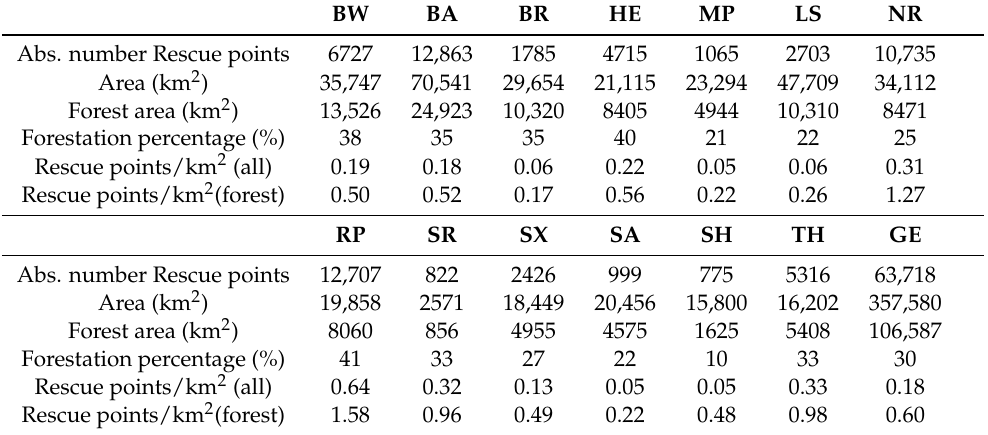
cumulative distribution of the individual distances for each of the RSPs within the forest area (n = 3,189,44). Table 2. Standard indices of the rescue point of the areas and the rescue points for the federal states and the federal level. Abbr.: Baden-Württemberg (BW), Bavaria (BA), Brandenburg (BR), Hesse (HE), Mecklenburg Western Pomerania (MP), Lower Saxony (LS), North Rhine-Westphalia (NR), Rhineland-Palatinate (RP), Saarland (SR), Saxony (SX), Saxony-Anhalt (SA), Schleswig-Holstein (SH), Thuringia (TH), Germany (GE).